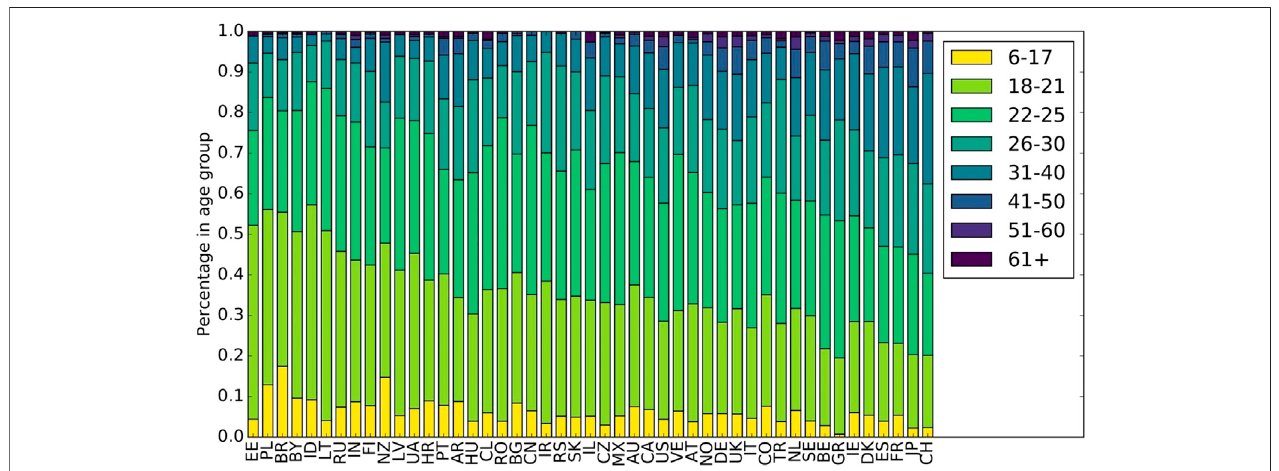
FIGURE 1 | Distribution of age over countries. Countries are sorted in decreasing order of number of users from left to